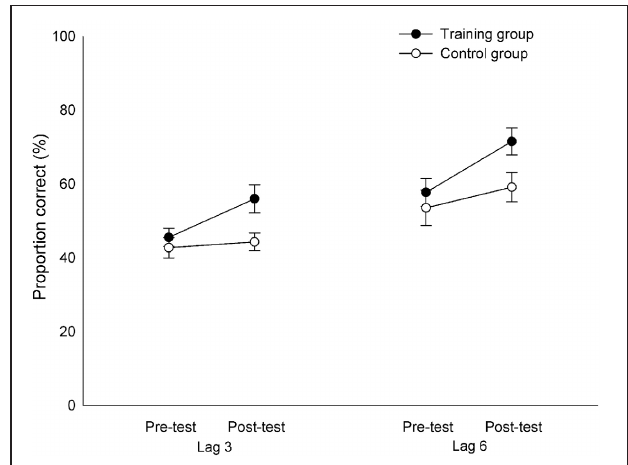
FIGURE 5 | Proportionof correctly reported T2|T1 for both lags in pre-test and in post-test for the training group and the control group. Error bars indicate standard errors of the